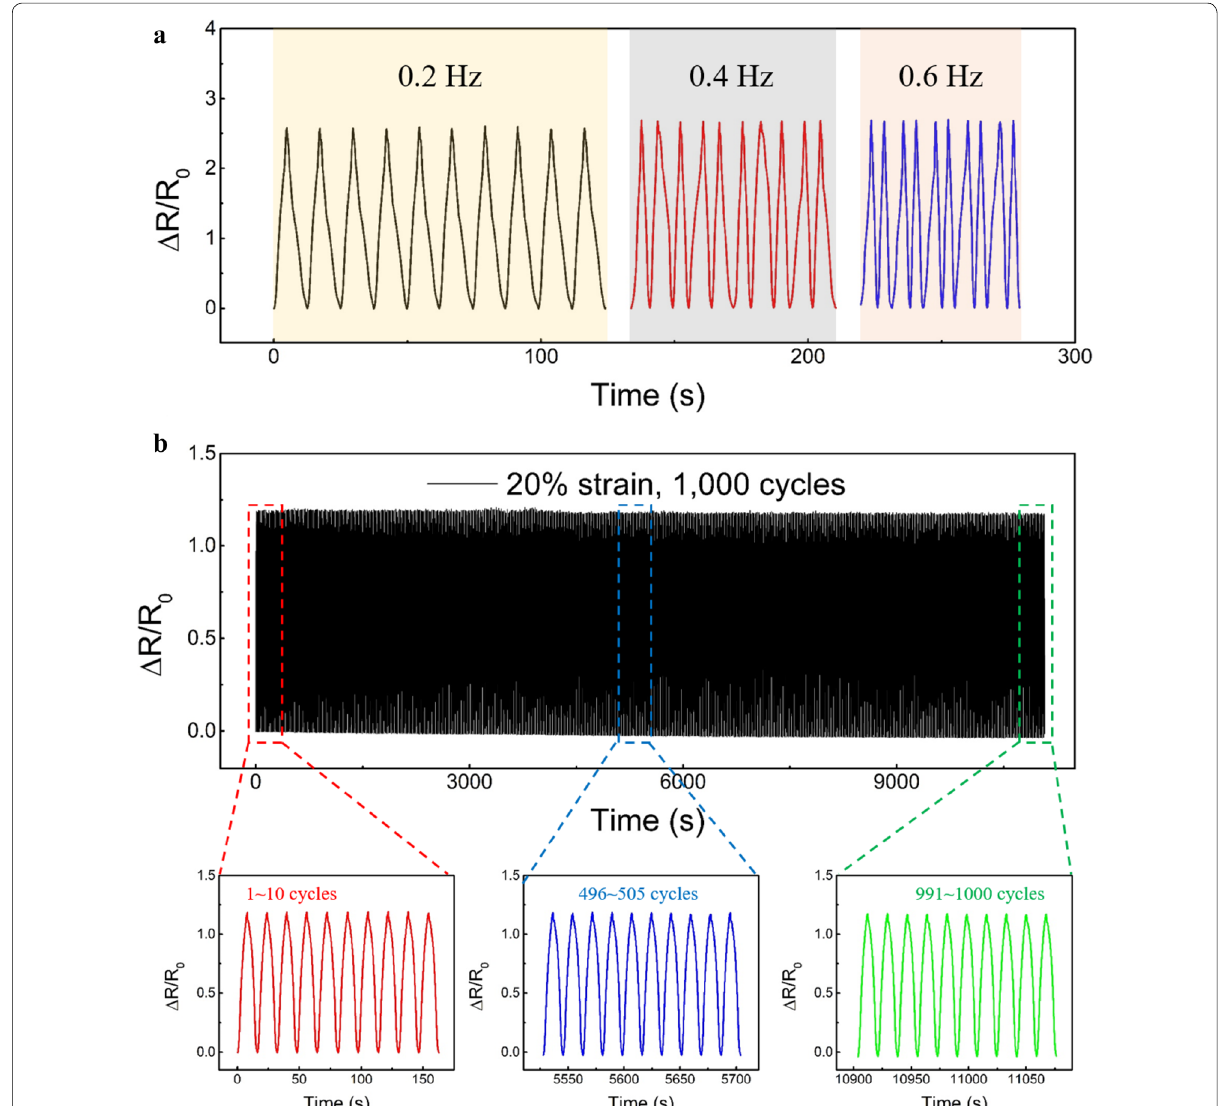
Fig. 6 The measured sensing performance of the piezoresistive strain sensor under dynamic loads. a The measurements of changes in resistance according to strain rate. b Full and enlargements of each 10 cycles measurement results of